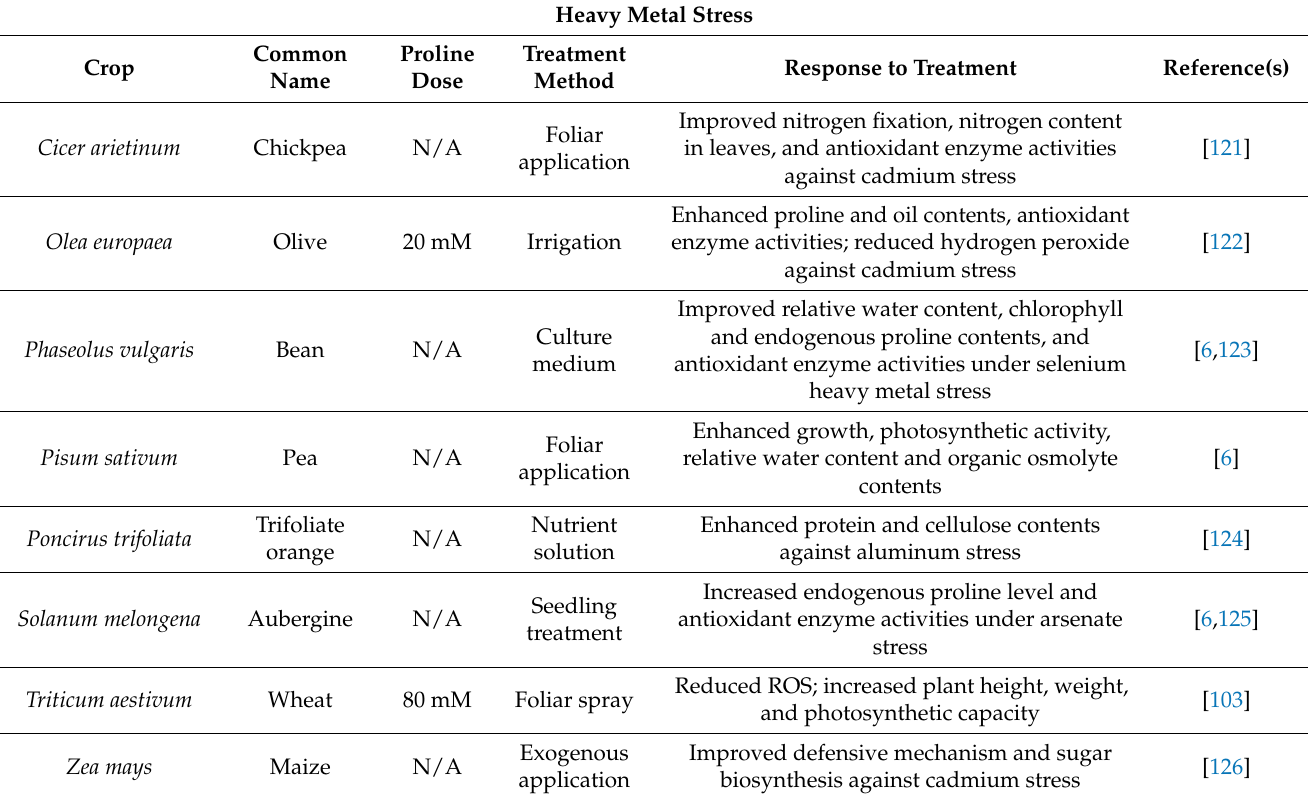
Table 15. Physiological responses of various crops to proline treatment against heavy metal stress. Heavy Metal